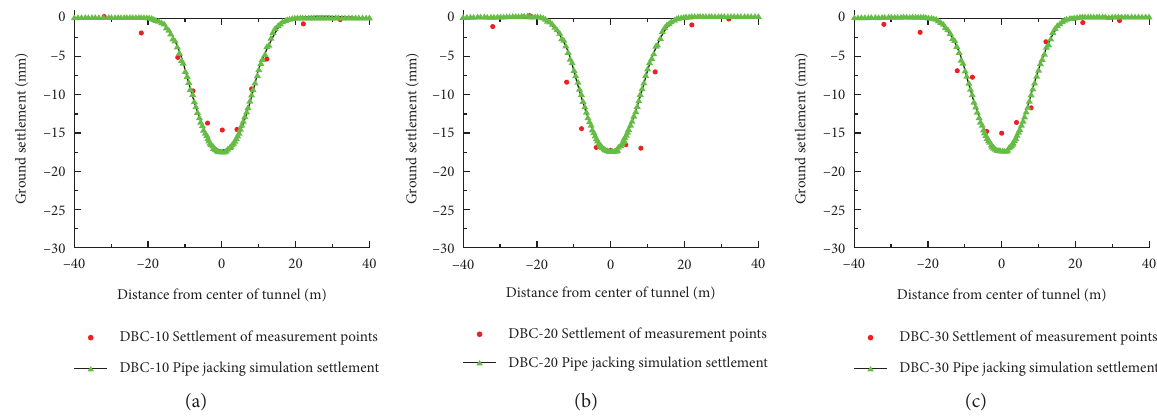
Figure 12: Final ground surface settlement of pipe jacking field measurement: (a) DBC-10. (b) DBC-20. (c) DBC-30.